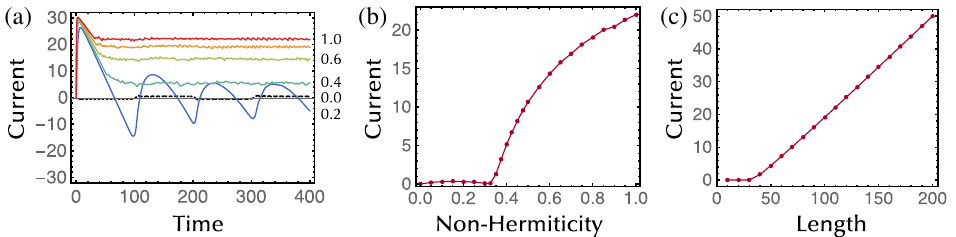
P L − 1 ψ ð t Þj ˆ I ψ ð t Þi in the Hatano-Nelson model with open boundaries ( J ¼ 1 . 0 ). The initial state FIG. 4. Total charge current I ð t Þ ≔ l j l ¼ 1 h is prepared as the charge density wave state in Eq. (4). (a) Time evolution of the current ( L ¼ 100 ) for γ ¼ 0 . 0 (black dashed curve), 0.2 (blue curve), 0.4 (green curve), 0.6 (light green curve), 0.8 (orange curve), and 1.0 (red curve). (b) Charge current for the steady state as a function of non-Hermiticity γ for L ¼ 100 . (c) Charge current for the steady state as a function of the system length for γ ¼ 0 . 8